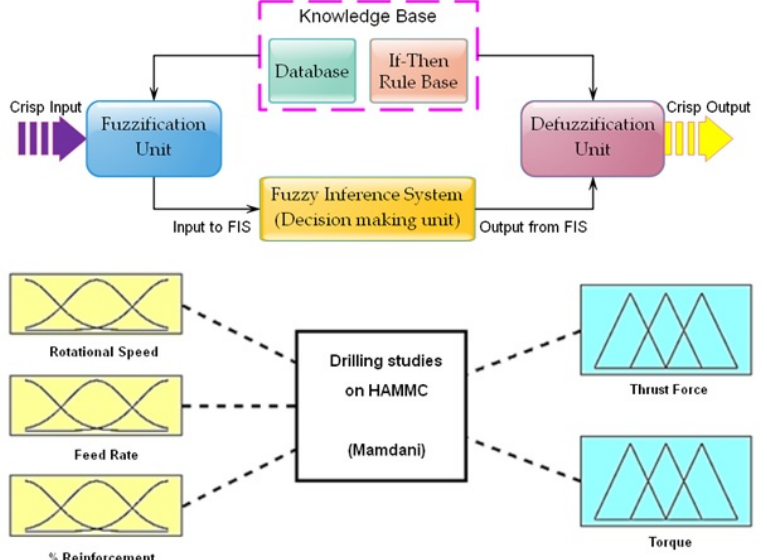
Metals 2021 , 11 , x FOR PEER REVIEW Figure 5. Functional elements of fuzzy interference system used in this research.